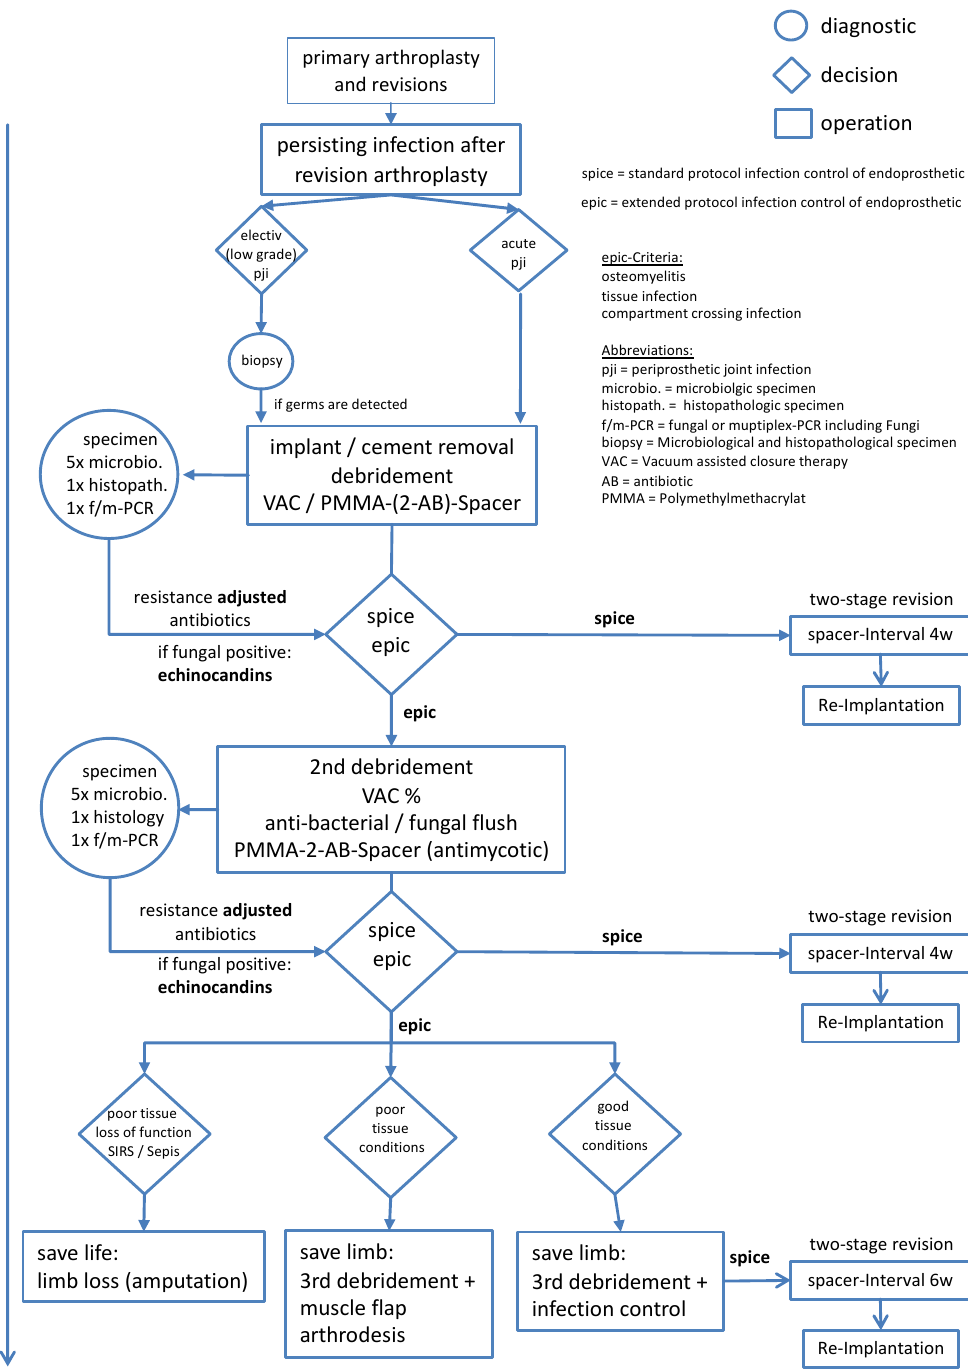
Figure 5. Therapy regimen. Scheme for the treatment of severe periprosthetic infections with the decision flow method for standardised therapy.